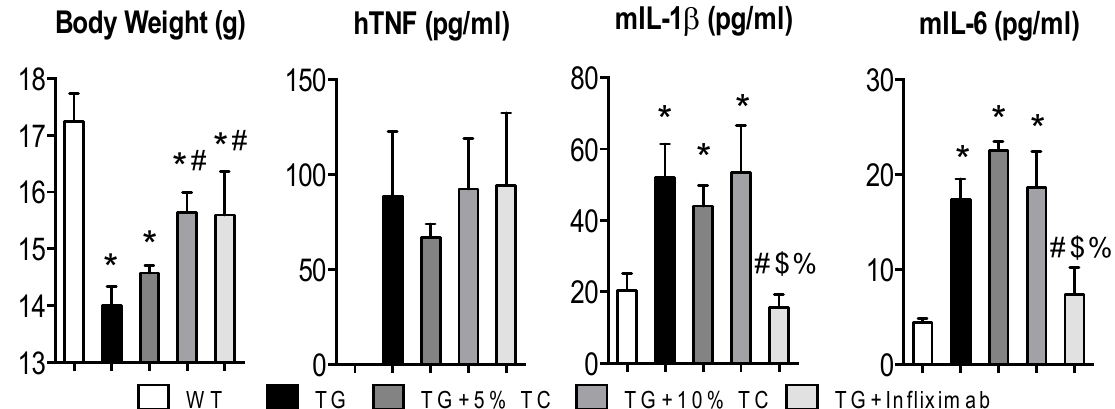
Figure 1. High-doses of TC recovered a TNF-mediated loss of body weight, but it did not suppress TNF-mediated elevation of proinflammatory cytokines in the blood. After 4 weeks of treatment, body weight was measured in wild-type (WT), transgenic (TG), TG with 5% TC, TG with 10% TC, and TG with infliximab mice. Collected serum after sacrifice was also used to measure protein levels of human TNF (hTNF), mouse interleukin (mIL)-1 β , and mIL-6. Values are mean ± SEM ( n = 4–8 per group). *, p < 0.05 vs. WT; #, p < 0.05 vs. TG; $, p < 0.05 vs. TG + 5% TC; %, p < 0.05 vs. TG + 10%